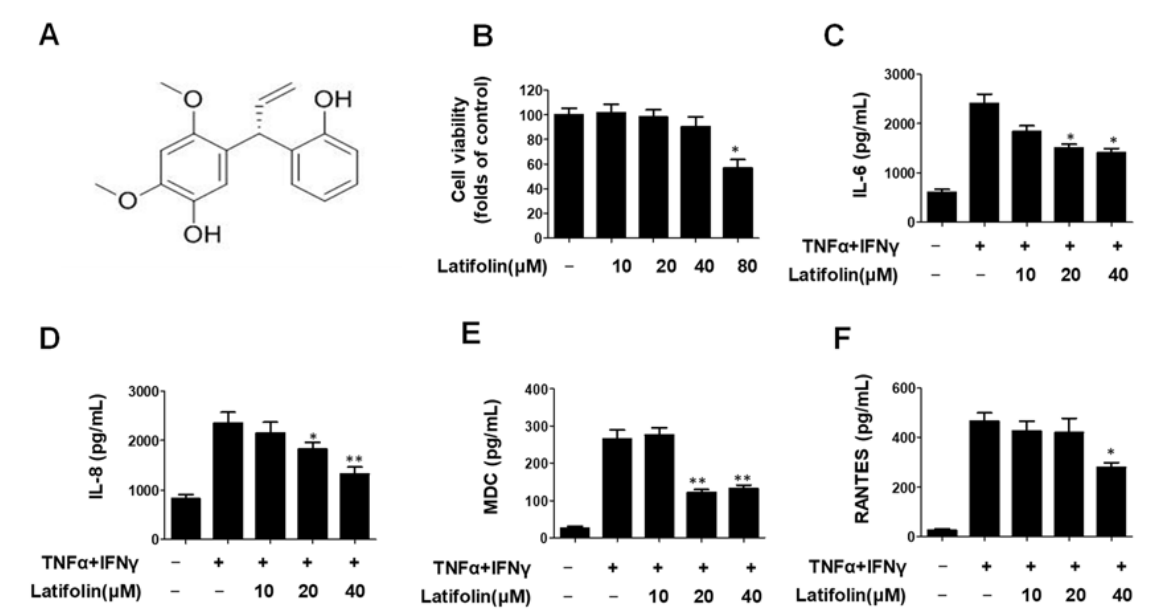
Figure 1. The chemical structure of latifolin ( A ) and its effects on cell viability ( B ), IL-6 ( C ), IL-8 ( D ), MDC ( E ), and RANTES ( F ) in TNF- α /IFN- γ -stimulated HaCaT cells. Cells were treated with latifolin (10–80 µM) for 24 h, and the cytotoxicity was evaluated. The cell culture supernatant was used to check ELISA kits. The data are represented as the mean ± SD ( n = 3). * p < 0.05, ** p < 0.01 vs. TNF- α /IFN- γ -treated group.